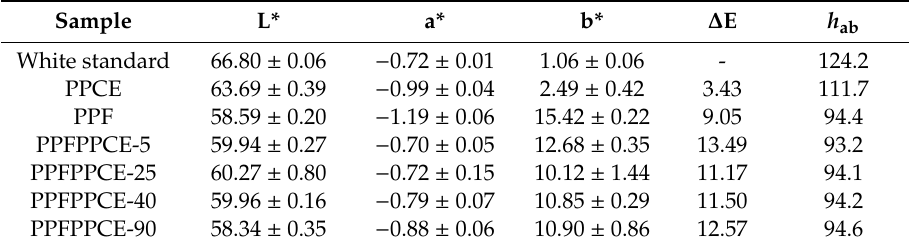
Table 4. L*, a*, b*, ∆ E, and h ab of PPCE, PPF, and PPFPPCE-t